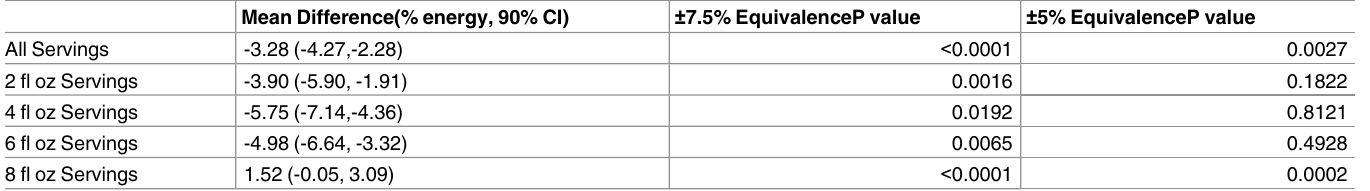
RFPM; hence, the RFPM underestimated intake by 4.8 ± 0.5 kcals. The Bland-Altman regres- sion plot (Fig 4B) showed a significant negative slope (proportional bias, R 2 = 0.20, p < 0.0001), indicating that the RFPM overestimated intake at lower levels of intake and underestimated intake with higher intakes. In 6 fl oz servings,direct weighing measured mean simulated for- mula intake as 101.1 ± 25.3 kcals, and the RFPM estimated mean intake as 94.9 ± 22.4 kcals Table 2. Mean percent difference and test of equivalence of simulated intake of formula prepared from powder between direct weighing and RFPM. Mean Difference(% energy, 90%